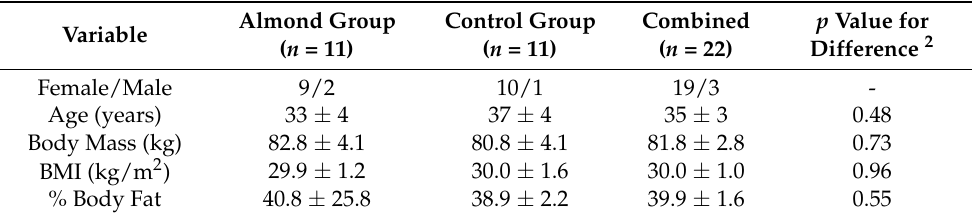
Table 2. Baseline subject characteristics 1 .